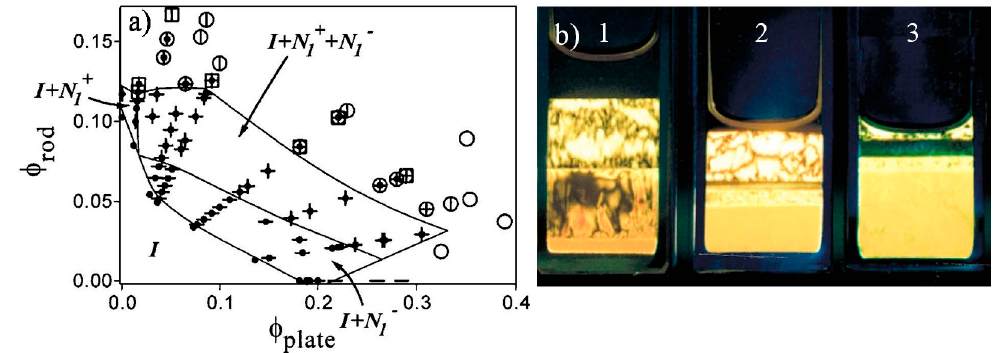
Figure 16. ( a ) Phase diagram for boehmite / gibbsite (nanocylinder / nanoplatelet). N + indicates a nematic phase of predominantly nanocylinders, and N − indicates a nematic phase of predominantly nanoplatelets. Filled circles indicate isotropic, vertical lines N 1 + , dashes N 1 − , open squares N 1 + , open circles N 2 − . ( b ) Polarized light images of concentrated dispersions of concentrations (boehmite, gibbsite) and top to bottom. (1) (0.06, 0.26) I + N 1 + + N 1 − + N 2 − , (2) (0.10, 0.22) I + N 1 + + N 2 + N 1 − + N 2 − , (3) (0.07, 0.29) N − . Reprinted with permission from van der Kooij,